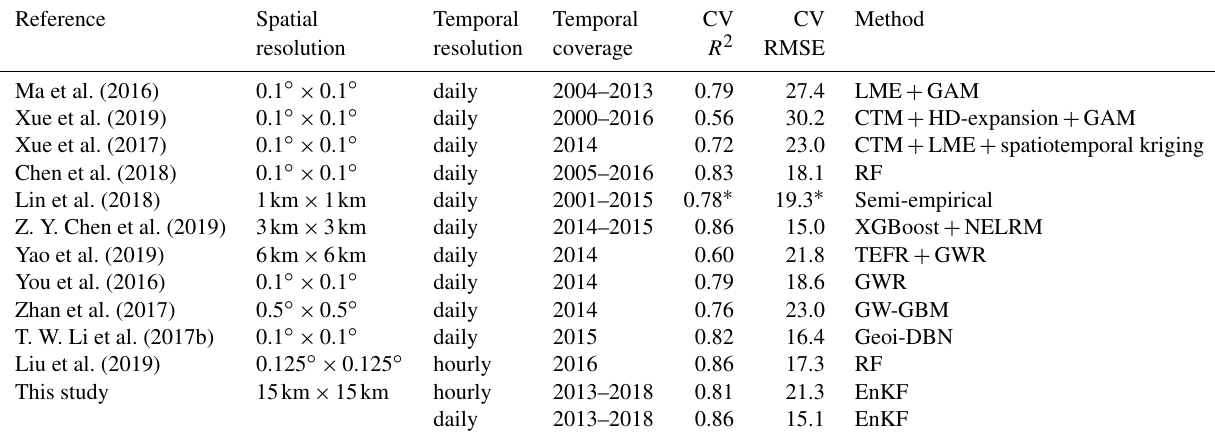
Table 5. Comparison of the accuracy of our PM 2 . 5 reanalysis data to those of satellite estimates.